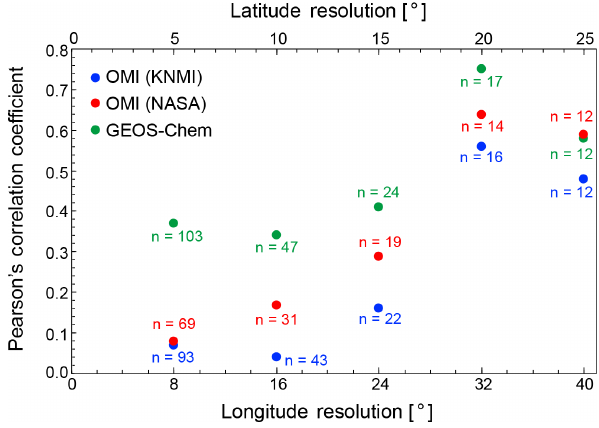
Figure 3. Evaluation of OMI and GEOS-Chem upper troposphere NO 2 with aircraft observations. Individual points are Pearson’s cor- relation coefficients between gridded March–August mean UT NO 2 measured from the aircraft and OMI KNMI in 2006 (blue), OMI NASA in 2005–2007 (red), and GEOS-Chem in 2006 (green) for grid averaging domains of 5 ◦ × 8 ◦ (latitude × longitude), 10 ◦ × 16 ◦ , 15 ◦ × 24 ◦ , 20 ◦ × 32 ◦ , and 25 ◦ × 40 ◦ . Inset values are the number of points at each resolution. The domain sampled is shown in Fig.